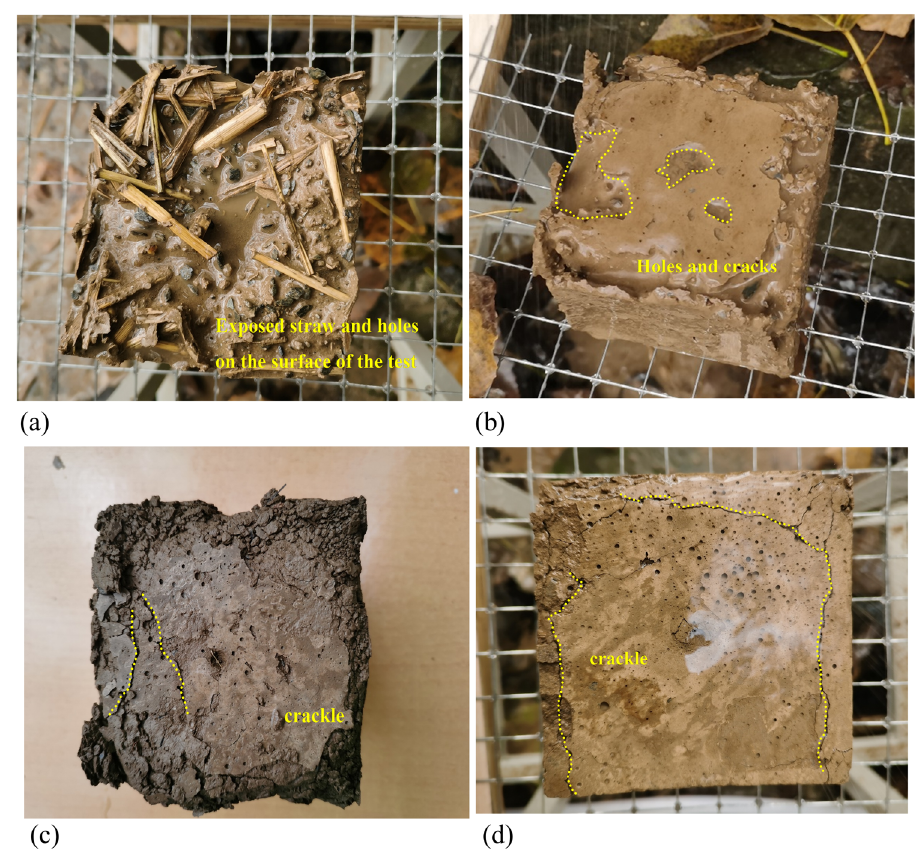
Figure 17: Test block after scouring: ( a ) straw; ( b ) starch; ( c ) cement; and ( d ) epoxy